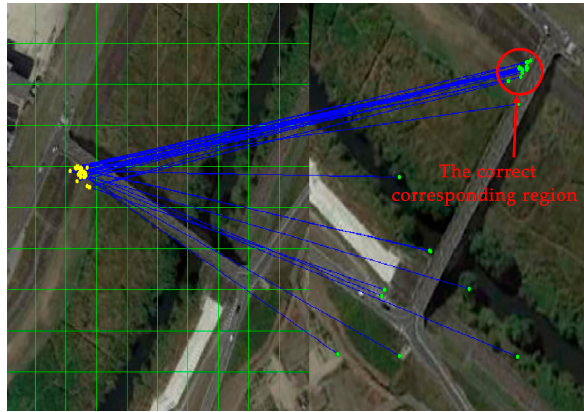
Figure 4. Feature points in a grid of the left image correspond to the match points of the right image. The red circle in the right image shows the true match points, which is characterized by aggregation.